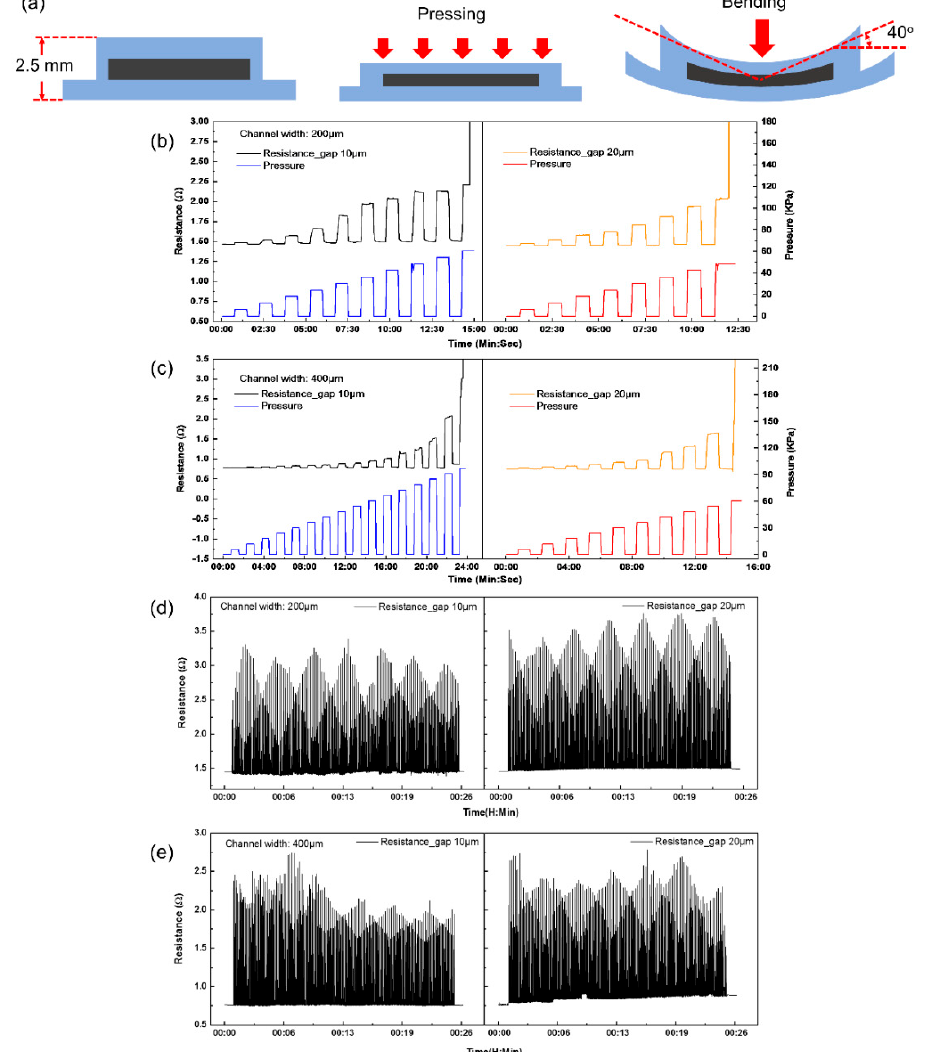
Figure 6. ( a ) Microheaters are subjected to pressing and bending. Resistance change of the with ( b ) 200 µ m-, ( c ) 400 µ m-wide liquid-metal heating channel under increasing pressure. Resistance microhearers with ( b ) 200 μ m-, ( c ) 400 μ m-wide liquid-metal heating channel under increasing change of the microhearers with ( d ) 200 µ m-, ( e ) 400 µ m-wide liquid-metal heating channel pressure. Resistance change of the microhearers with ( d ) 200 μ m-, ( e ) 400 μ m-wide liquid-metal heating channel under cyclic bending.